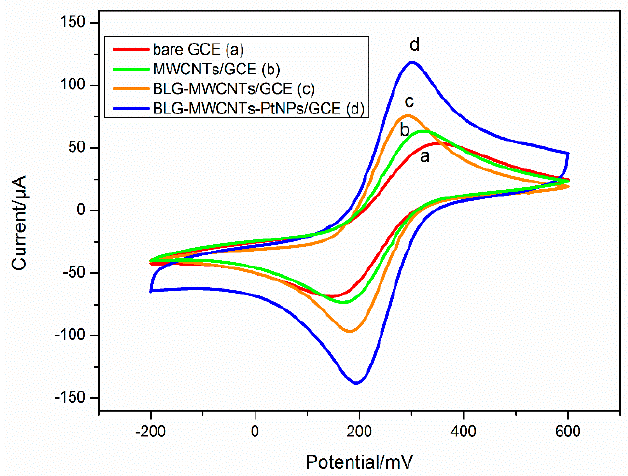
Figure 2. Cyclic voltammograms (CVs) of GC electrode ( a ), MWCNTs modified GC electrode ( b ), BLG-MWCNTs modified GC electrode ( c ) and BLG-MWCNTs-PtNPs modified GC electrode ( d ) scanned in 0.1 M KCl solution with 10 mM [Fe(CN) 6 ] 3 − .